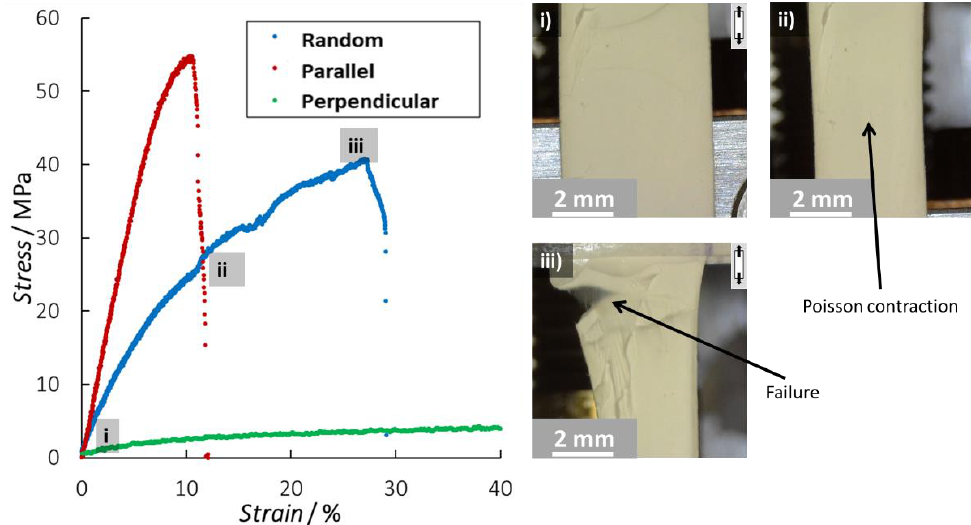
Figure 2. Representative tensile tests on pristine PA6 nanofiber membranes, combined with images of the progressive failure stages of a random nanofiber membrane. Figures ( i – iii ) show the deformation of the membrane at different stages of the stress–strain curve. Similar deformation behavior is observed for the samples with parallel and perpendicular aligned nanofibers (see Supporting Information Figure S1). No fracture was obtained for the perpendicular samples due to the travel limits of the used tensile stage. Table 1. Overview of the mechanical data of all tested membranes. The strength is determined based on the nominal cross-section of the